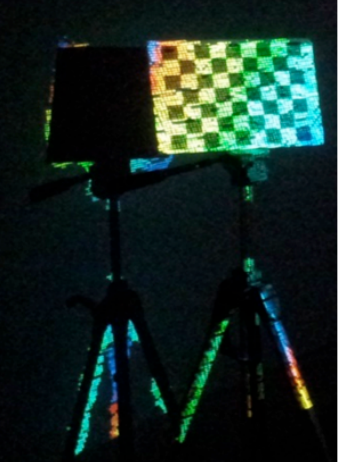
Figure 15 – Chessboard on a tripod under Depth Mapping with Cyclic Scale. Figure 16 (left) allows the visualization of even more depth levels, accurately emphasizing the differences of distances between the shoulders, the torso and the hands. On Figure 17 (right) the colors information obtained by the Kinect’s RGB camera accurately overlaps the objects contained in the scene. On Figure 17 (left) is presented the Mapping Skeleton accurately overlapping the user. Both Figure 16 and Figure 17 are examples of non-smooth